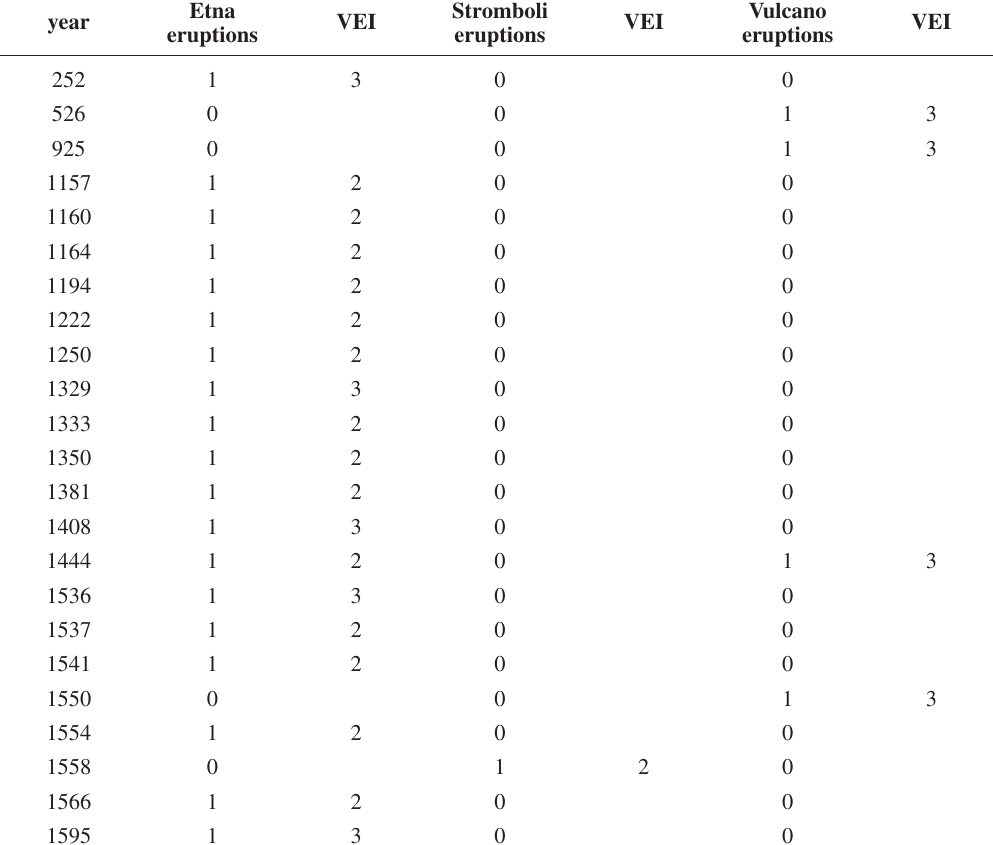
Table IV. Eruption (with VEI ≥ 2) occurrences by year between 0 and 1993 AD at Etna, Stromboli, and Vulcano. VEI = Volcanic Explosivity Index; 0 = no occurrence; 1 = occurrence. Data are from Simkin and Siebert